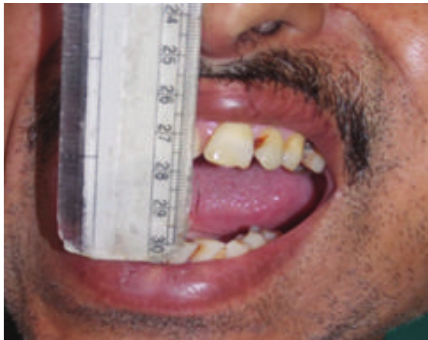
Figure 2: Preoperative picture shows mild trismus with MO of 23 mm.